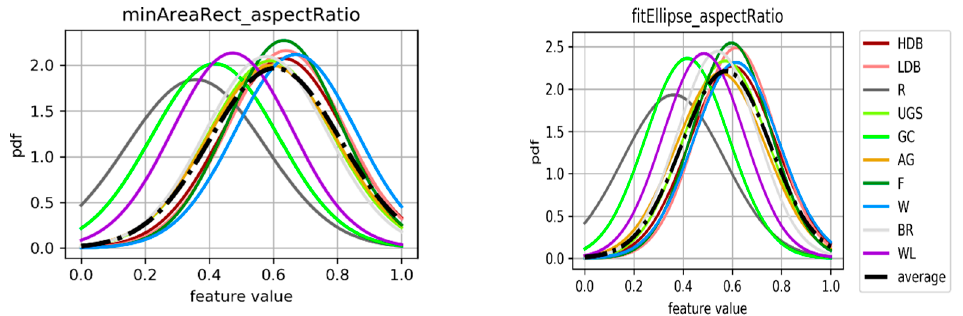
Figure 14. Classes histograms for two geometric features (Stockholm).